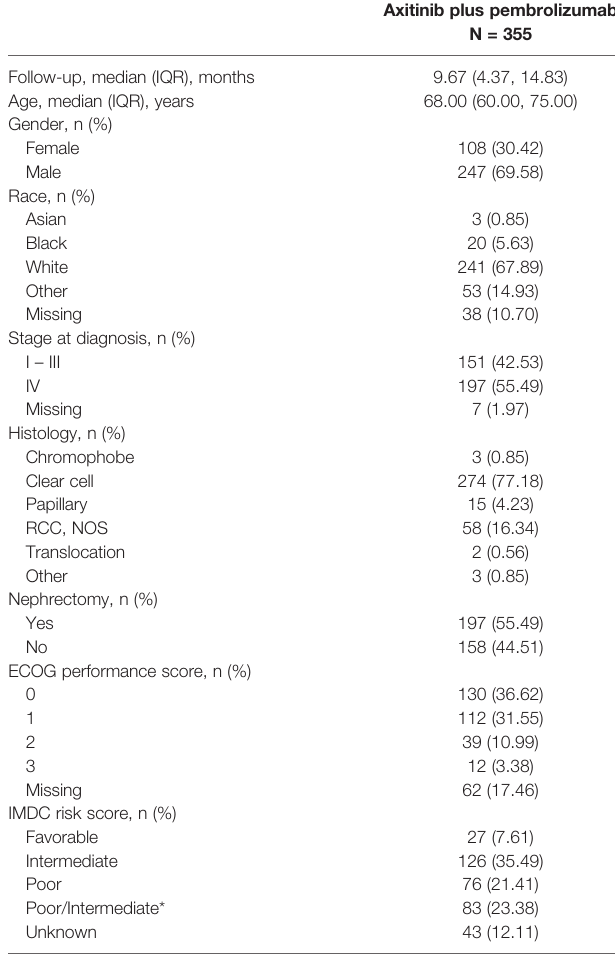
TABLE 1 | Patient demographics and clinical